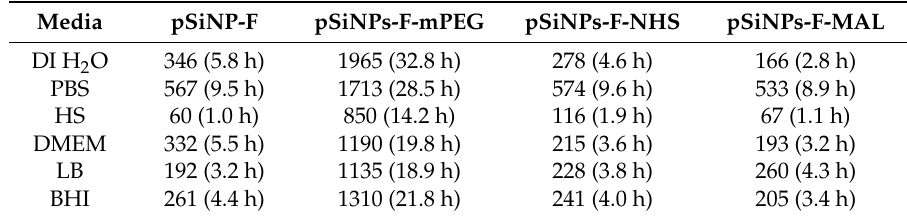
Table 2. Calculated half-degradation time-points for the pSiNPs samples. 1 Unit: min.